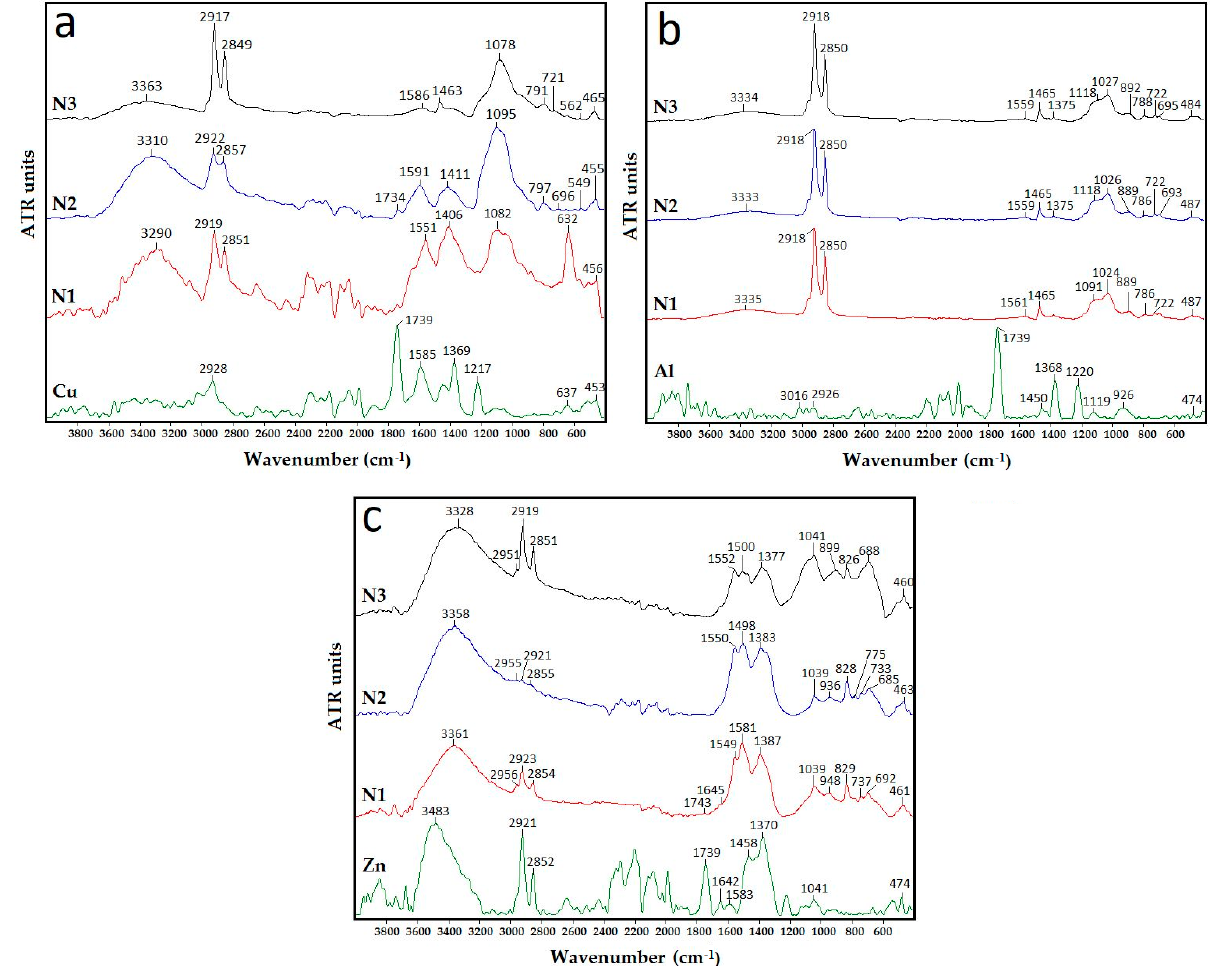
Figure 3. ATR-FTIR spectra of uncoated metallic substrates and of coated metallic substrates with ZnO-NPs modified with silane precursors (N1-TEOS/OTES, N2-TEOS/GPTMS, N3-TEOS/ODTES): ( a ) Cu, ( b ) Al and ( c ) Zn.